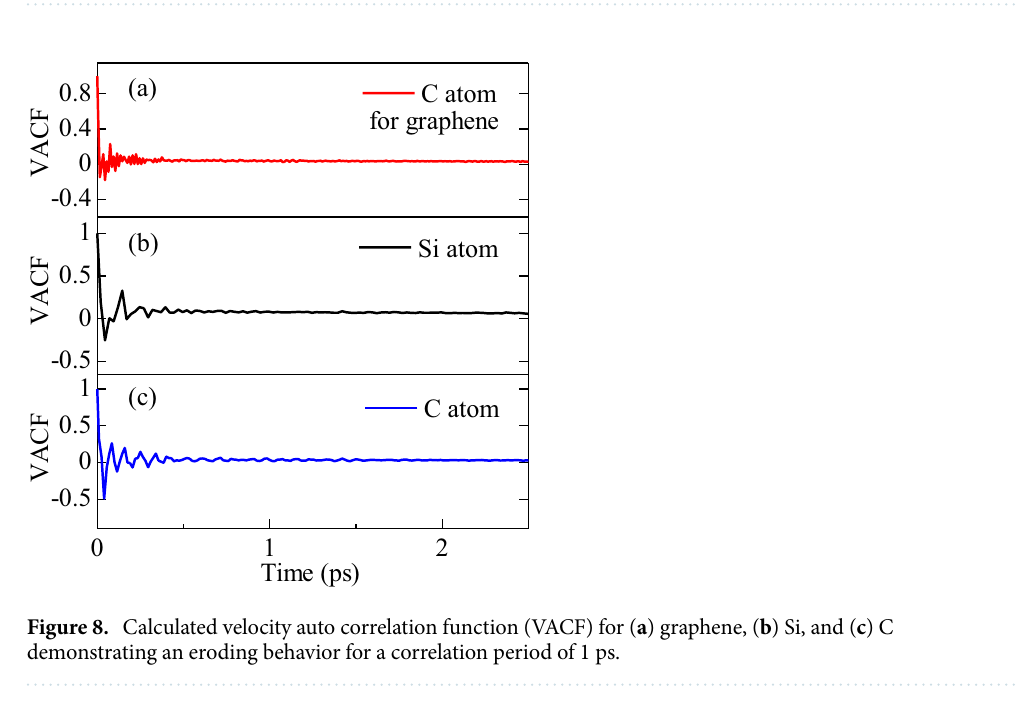
Figure 7. Comparison of the graphene/2D-SiC heterobilayer in-plane thermal conductivity between the original (triangle) and the optimized (circle) Tersoff potential.